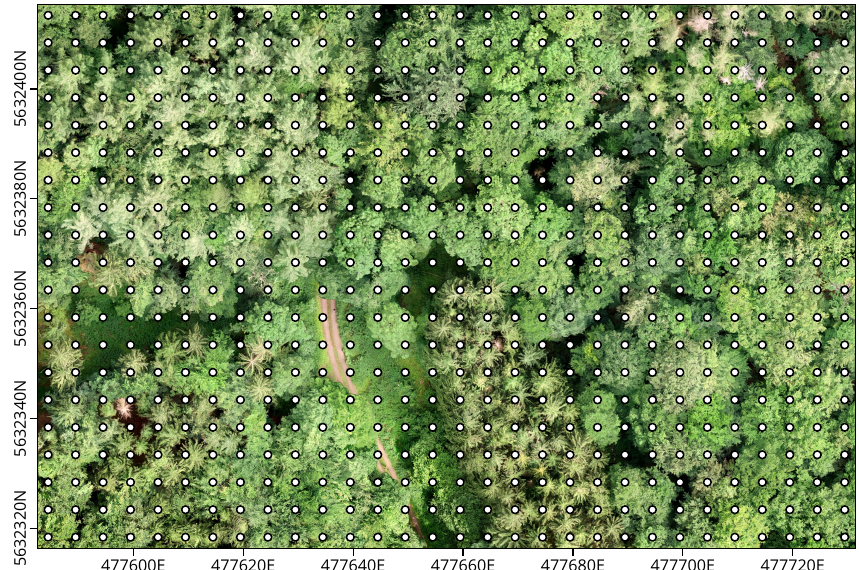
Figure 5. Orthophoto of the grid application region recorded on 2 July 2020. White dots mark points where photos were taken during the automated 5m × 5m grid flight. Coordinates are given in UTM zone